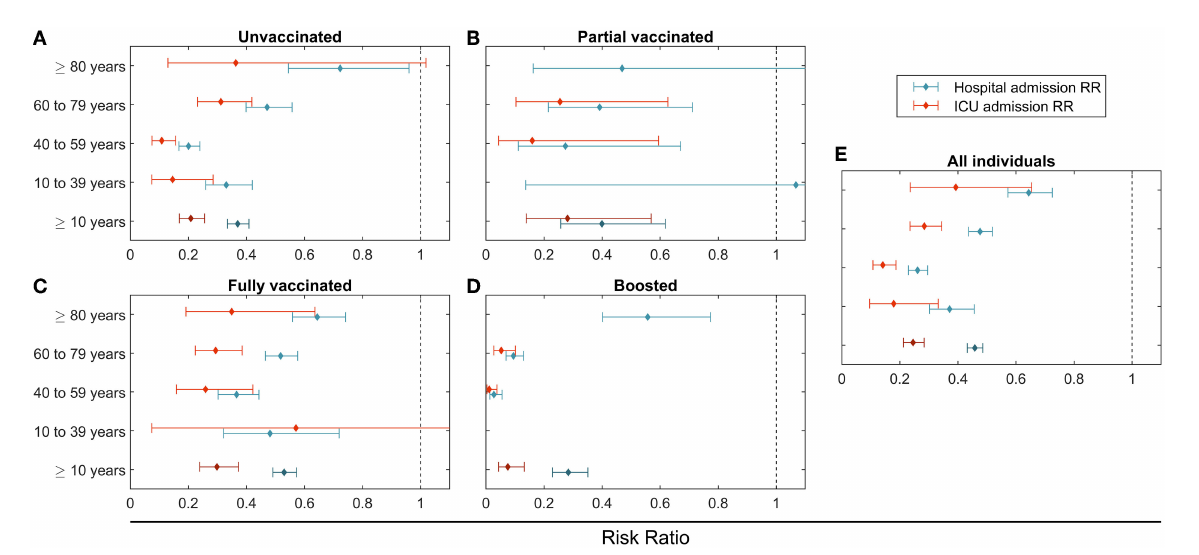
FIGURE2 Rate ratio (RR) estimation between omicron and delta cohorts for the different vaccination status (A–E) and age groups (vertical axes). Hospital admission RR in blue and intensive care unit admission RR in red. (A) Unvaccinated; (B) Partial vaccinated; (C) Fully vaccinated; (D) Boosted; (E) All individuals.